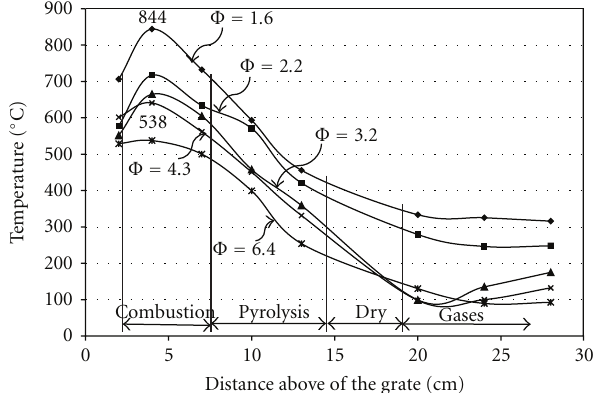
Figure 2: Temperature profile along the gasifier axis for gasification of DBWC blend at S : F = 0 . 80, adapted from